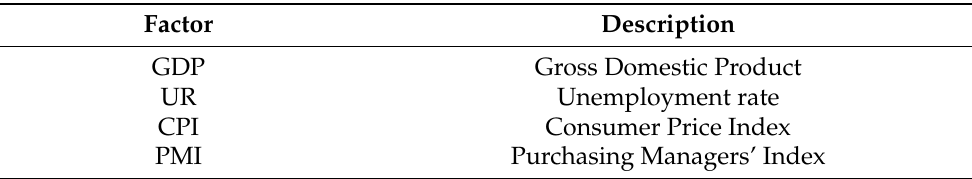
Table 1. Economical factors used in the simulation study.